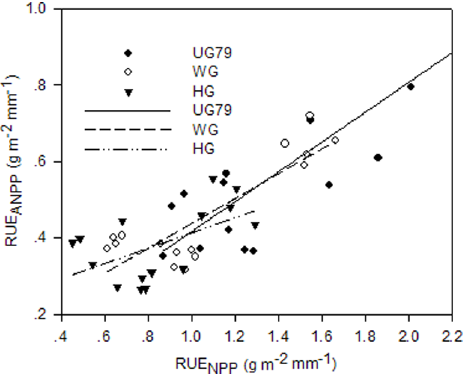
Figure 2. Relationship between RUE ANPP (g m 2 2 mm 2 1 ) and RUE NPP (g m 2 2 mm 2 1 ). The data were from three differently managed sites in 2004, 2005 and 2006. The regression equations for UG79: y = 0.025 + 0.391 x, r 2 = 0.673, n = 15, P , 0.001; for WG: y=0.112 + 0.326 x, r 2 =0.742, n=15, P , 0.001; for HG: y=0.213 + 0.201 x, r 2 =0.306, n=15, P=0.029. UG79= ungrazed site since 1979; WG=winter grazing site; HG=heavy grazing site; RUE ANPP =rain-use efficiency based on aboveground net primary productivity; RUE